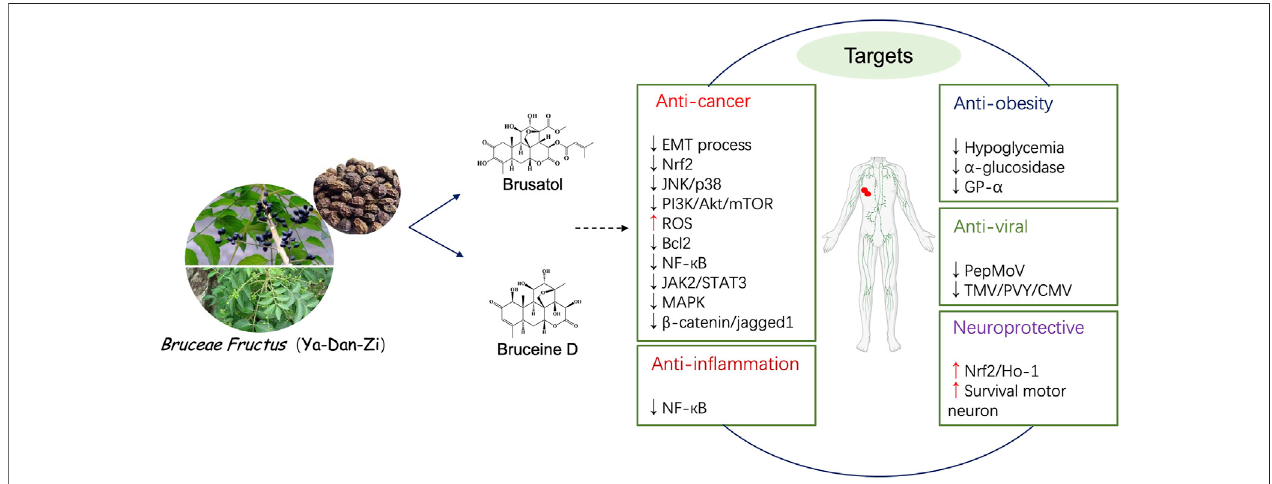
FIGURE 2 | Schematic presentation of the pharmacological activities of brusatol and bruceine D, the two main constituents of B. javanica